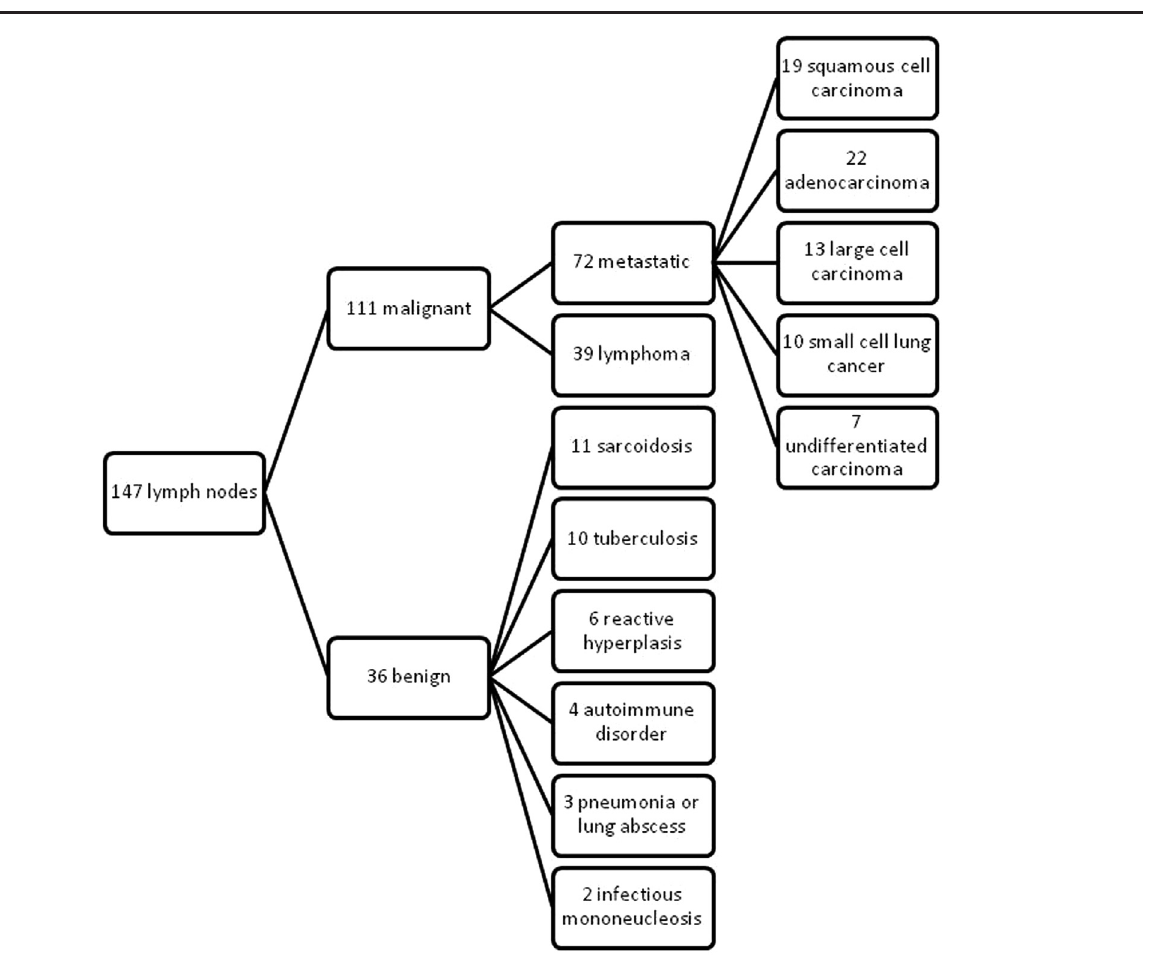
Diagram shows the cytological diagnosis of the examined lymph